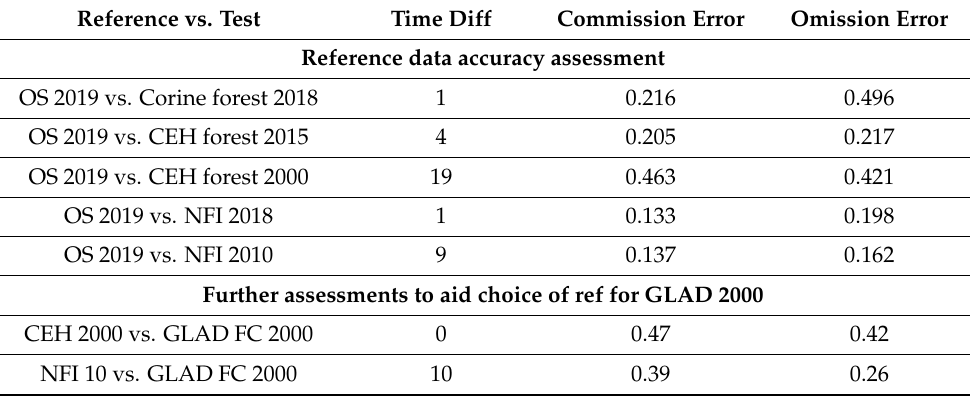
Table 3. Accuracy results comparing OS with CEH, NFI, and Corine data. Reference vs. Test